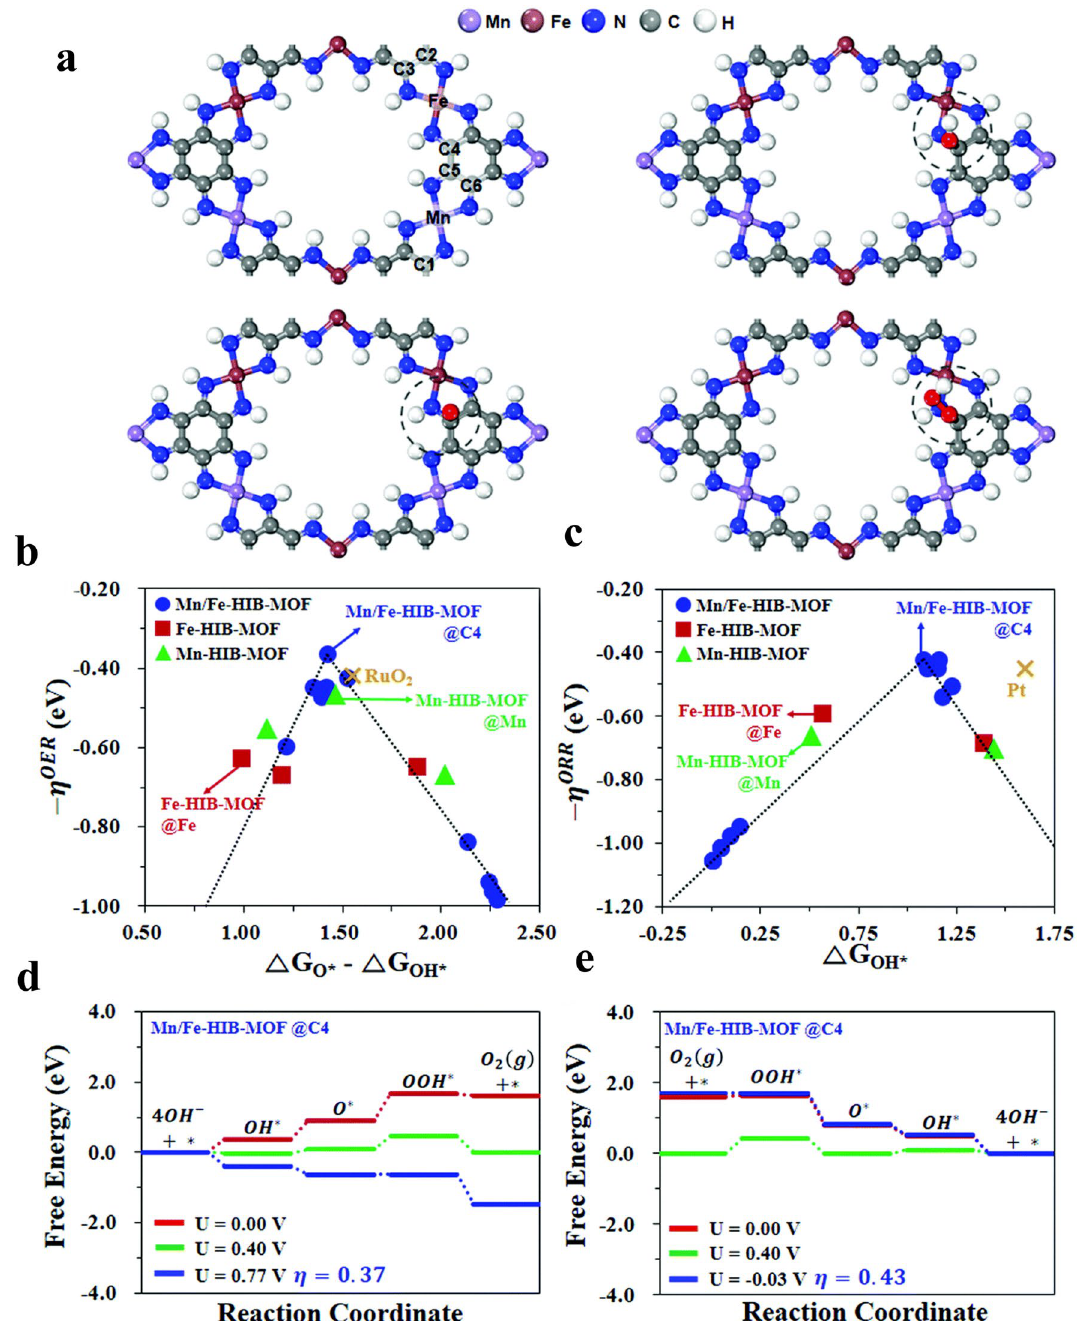
Fig. 4 Mechanistic study of bifunctionality for OER and ORR. a Initial structure and structures after the adsorption of hydroxyl OH*, oxyl O*, and hydroperoxyl OOH* intermediates on Mn/Fe-HIB-MOF. (Inset: active sites with elements and Arabic numbers.) Volcano profiles for b OER and c ORR for Mn-HIB-MOF, Fe-HIB-MOF, and Mn/Fe-HIB-MOF catalysts. Free energy diagrams on Mn/Fe-HIB-MOF in an alkaline envi-